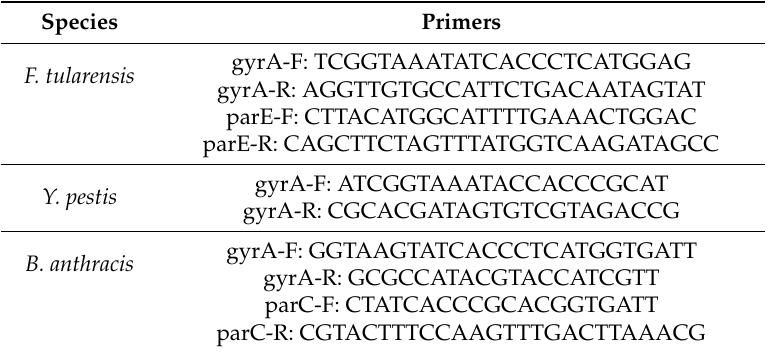
Table 14. Primers, probes for HRMA, derived from Loveless